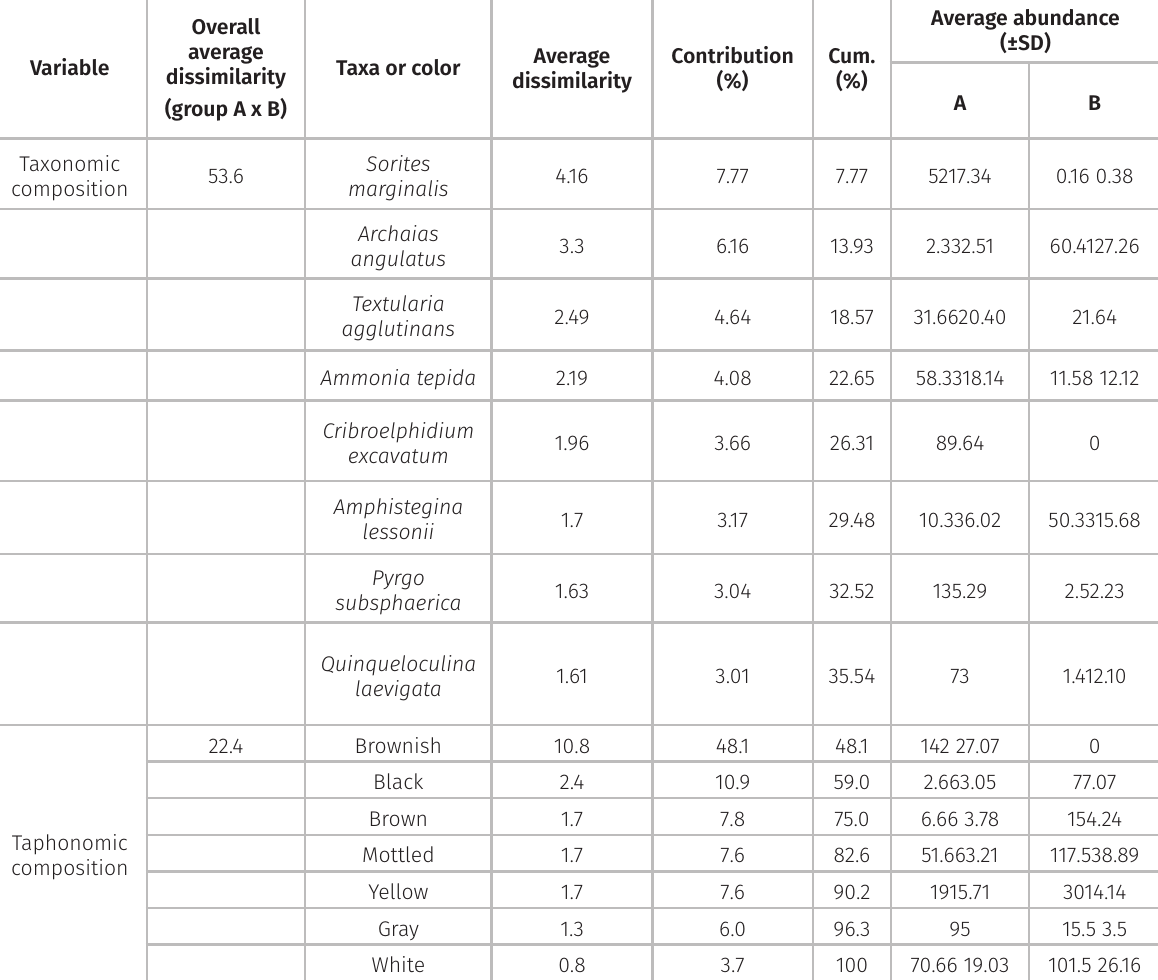
Table II. Results of the SIMPER analysis, indicating the average dissimilarity between the groups formed by the cluster according to the taxonomic and taphonomic composition and the species/colors that mostly contributed to the